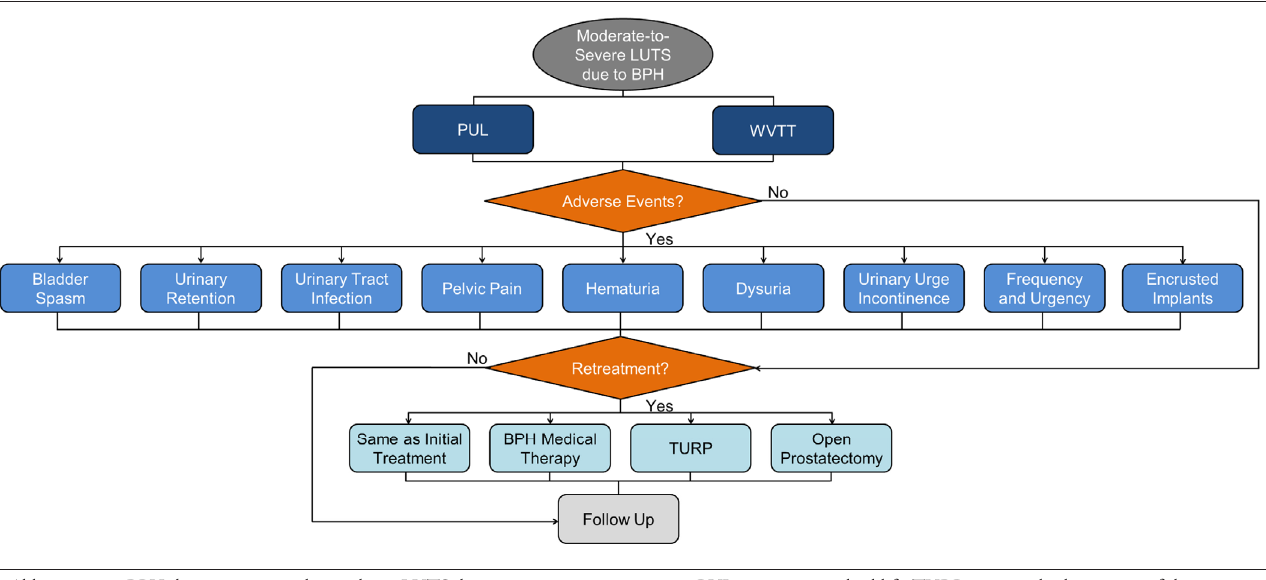
Abbreviations: BPH, benign prostatic hyperplasia; LUTS, lower urinary tract symptoms; PUL, prostatic urethral lift; TURP, transurethral resection of the prostate; WVTT, water vapor thermal